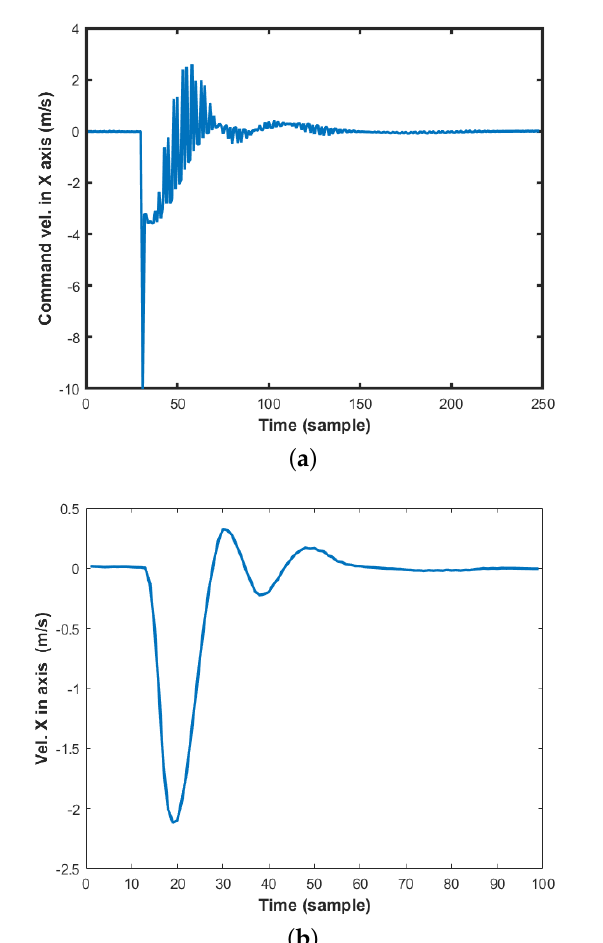
Figure 12. ( a ) Commanded; and ( b ) Measured velocities.